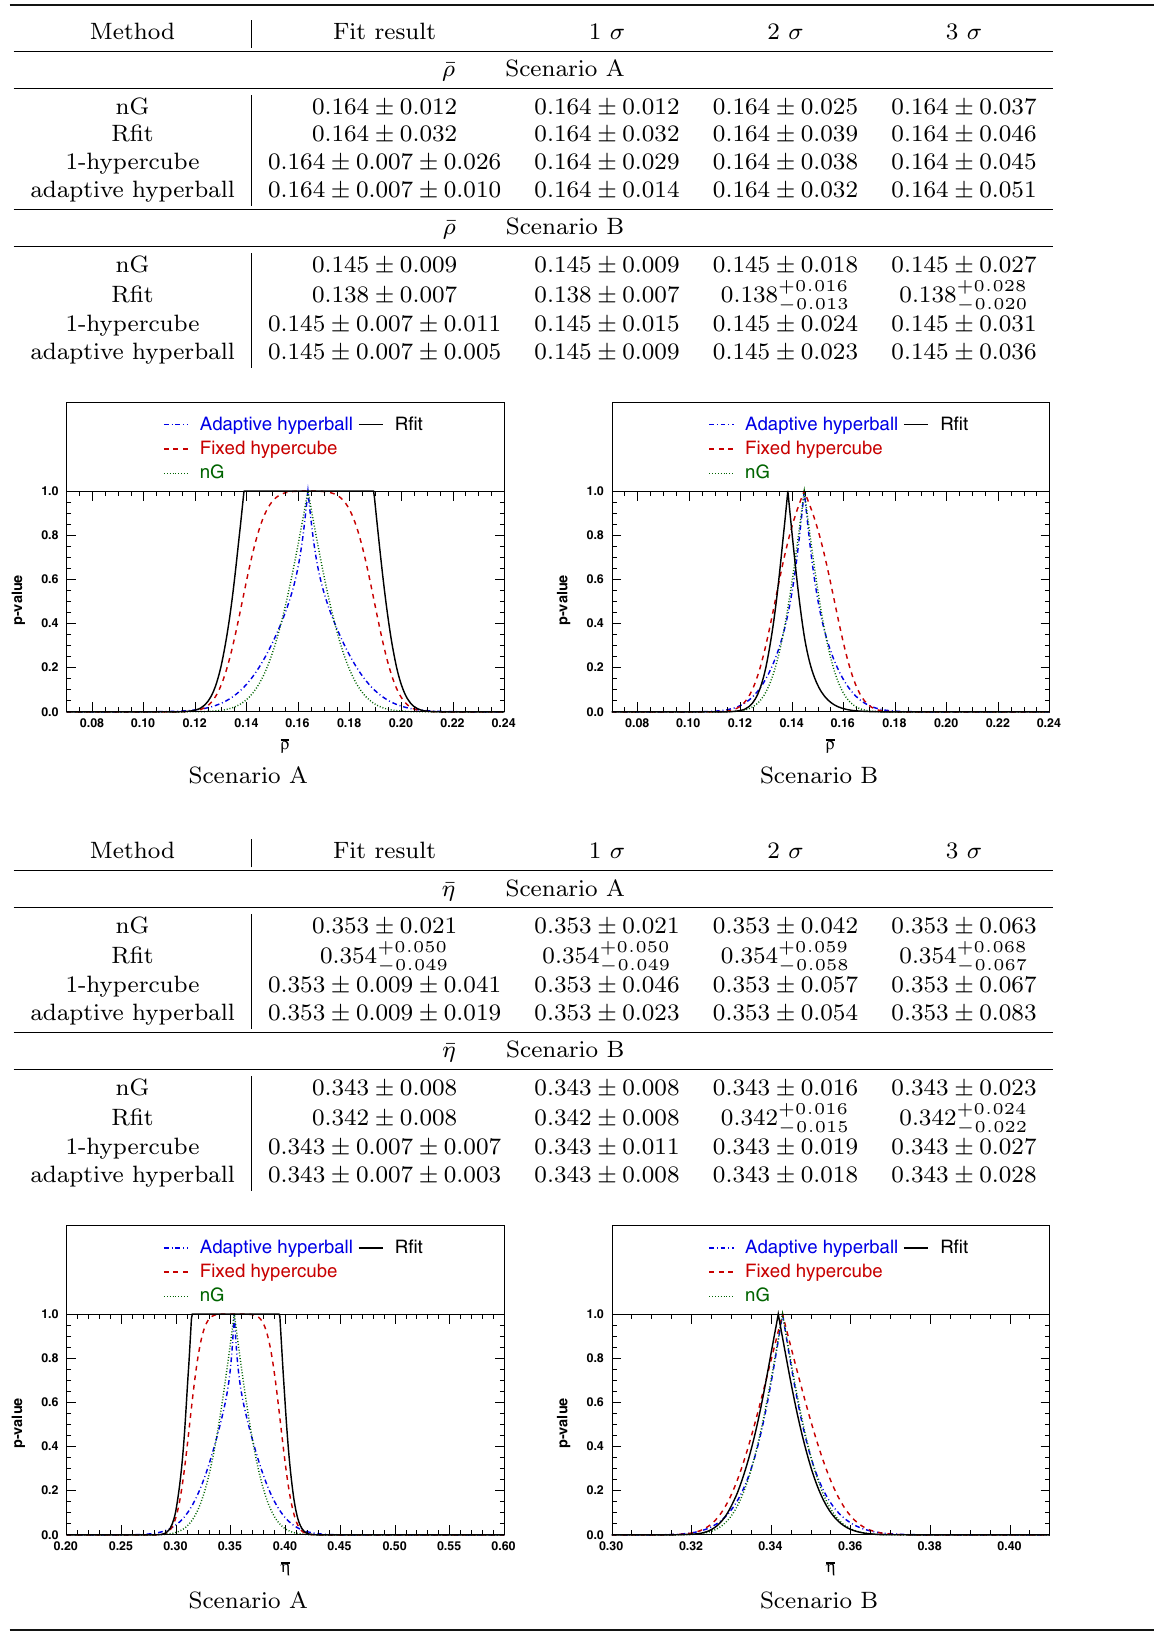
Table 14 Numerical results and p values for the CKM parameters in ¯ ρ and ¯ η for Scenarios A and B, depending on the method chosen. For each quantity, we provide the error budget, whenever possible, and the plots of the p values for Scenarios A (left) and B